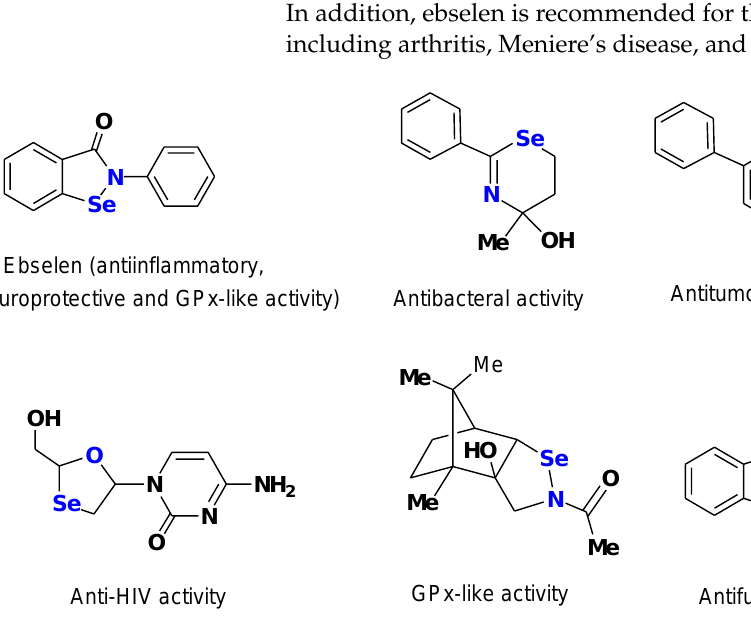
Figure 1. Examples of selenium heterocycles with biological activity.